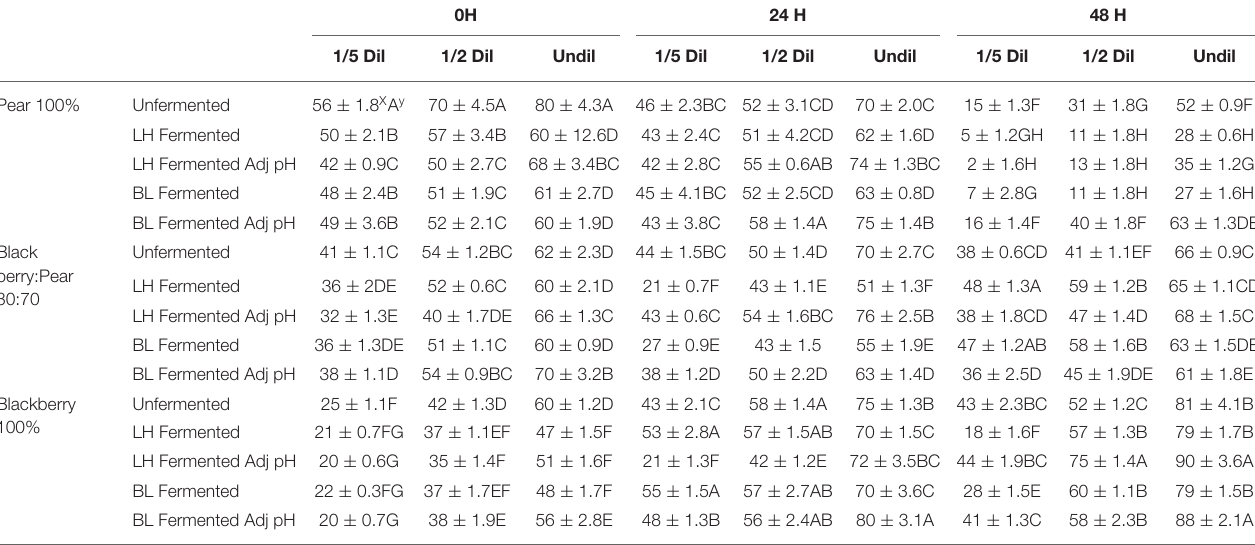
X ± Standard Error. y Differentuppercaselettersineachcolumnrepresentstatisticallysignificant(p ≤ 0.05)differencesin α -glucosidaseenzymeinhibitoryactivitybetweenfruitsampleextract × fermentation treatment interactions separately for each dilution and each fermentation time